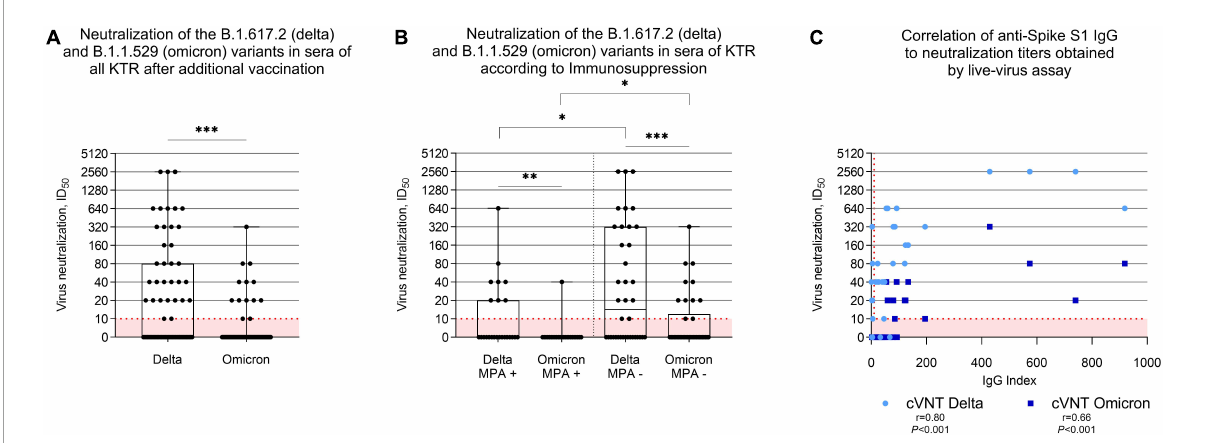
FIGURE4 Neutralization of the SARS-CoV-2 B.1.617.2 (delta) and the B.1.1.529 (omicron) variants by antibodies in sera of 69 kidney transplant recipients after an additional mRNA-1273 vaccine dose. (A) Vaccine-induced cross-neutralization of the B.1.617.2 (delta) and the B.1.1.529 (omicron) variants by antibodies in sera of 69 kidney transplant recipients (KTR) after an additional mRNA-1273 vaccine dose as determined by using a live-virus assay. The dashed red line indicates the cut-off for detection which is the 1:10 dilution in this assay. (B) Cross-neutralization of the B.1.617.2 (delta) and the B.1.1.529 (omicron) variants by antibodies in sera of 62 KTR with maintenance immunosuppressive therapy consisting of a calcineurin inhibitor (CNI), mycophenolic acid (MPA), and corticosteroids (CS) stratified according to temporary MPA withdrawal during additional vaccination. (C) Correlation analysis of anti-S1 IgG results obtained by a commercially available assay with cross-neutralization titers of the B.1.617.2 (delta) and the B.1.1.529 (omicron) variants by sera of kidney transplant recipients taken after an additional mRNA-1273 vaccine dose. KTR with breakthrough infections ( N = 9) were excluded from the analyses. cVNT, conventional virus neutralization test; ID 50 ; inhibitory dilution 50; KTR, kidney transplant recipients; MPA, mycophenolic acid; r; Spearman’s rho; ∗∗∗ P < 0.001; ∗∗ P < 0.01; ∗ P <